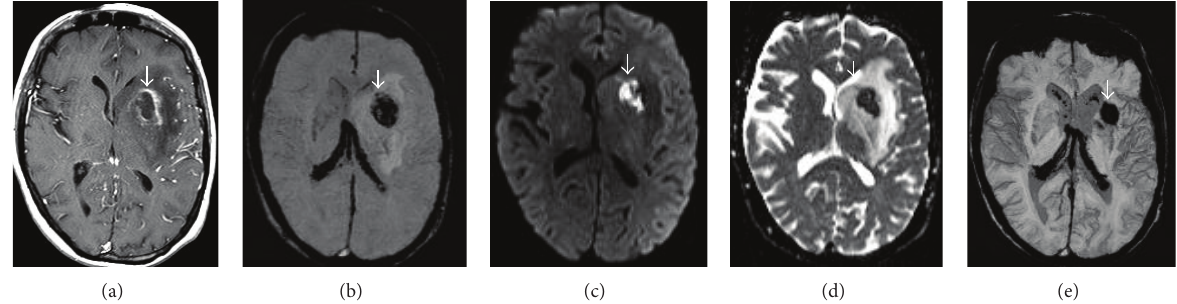
Figure 2: (a) Postgadolinium T1 SE image shows the enhancing wall of the abscess (arrow). Note the prominent surrounding vasogenic edema with mass effect on the left lateral ventricle. (b) Susceptibility weighted image shows profound hypointensity (arrow) in the wall from presence of hemorrhage. Vasogenic edema shows hyperintense signals. (c) Diffusion image demonstrates bright signals due to restricted diffusion from the pus in the center of the abscess (arrow). (d) Apparent diffusion coefficient (ADC) map shows corresponding dark signals confirming true restricted diffusion in the center of the abscess (arrow). (e) Susceptibility weighted image at 6 months followup demonstrates residual hemosiderin in the healed abscess (arrow). Note the resolved edema and mass effect on the left lateral ventricle.